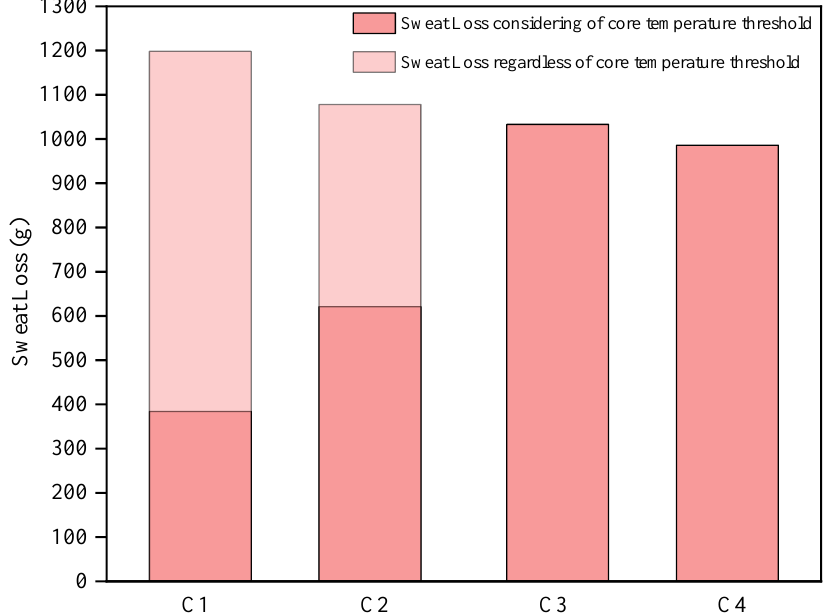
Figure 9. The predicted sweat loss of grid workers in 240 min under different work/rest strategies (C1: a 240-min work; C2: a 30-min rest after a 60-min work; C3: a 45-min rest after a 60-min; C4: a 60-min rest after a 60-min